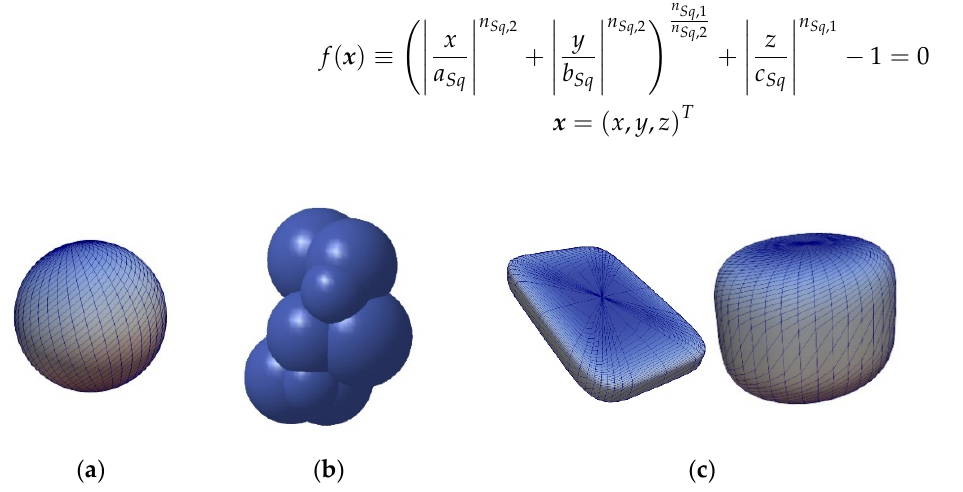
Figure 5. Representation of particle shapes in simulation environment. ( a ) sphere; ( b ) multisphere; ( c ) superquadric.